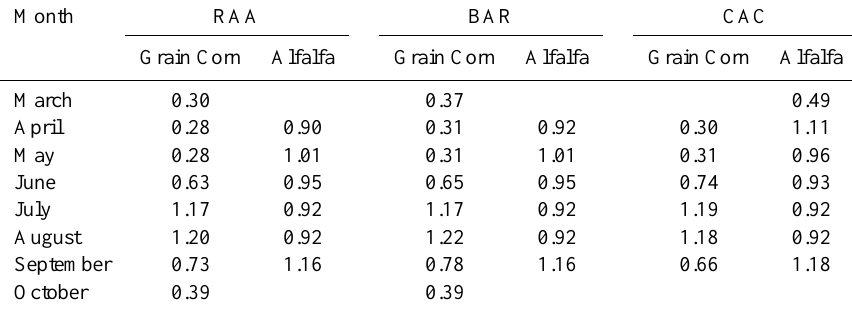
Table 2. Monthly values of K c for grain corn and alfalfa at three study irrigation districts: Riegos del Alto Arag´on (RAA), Canal de